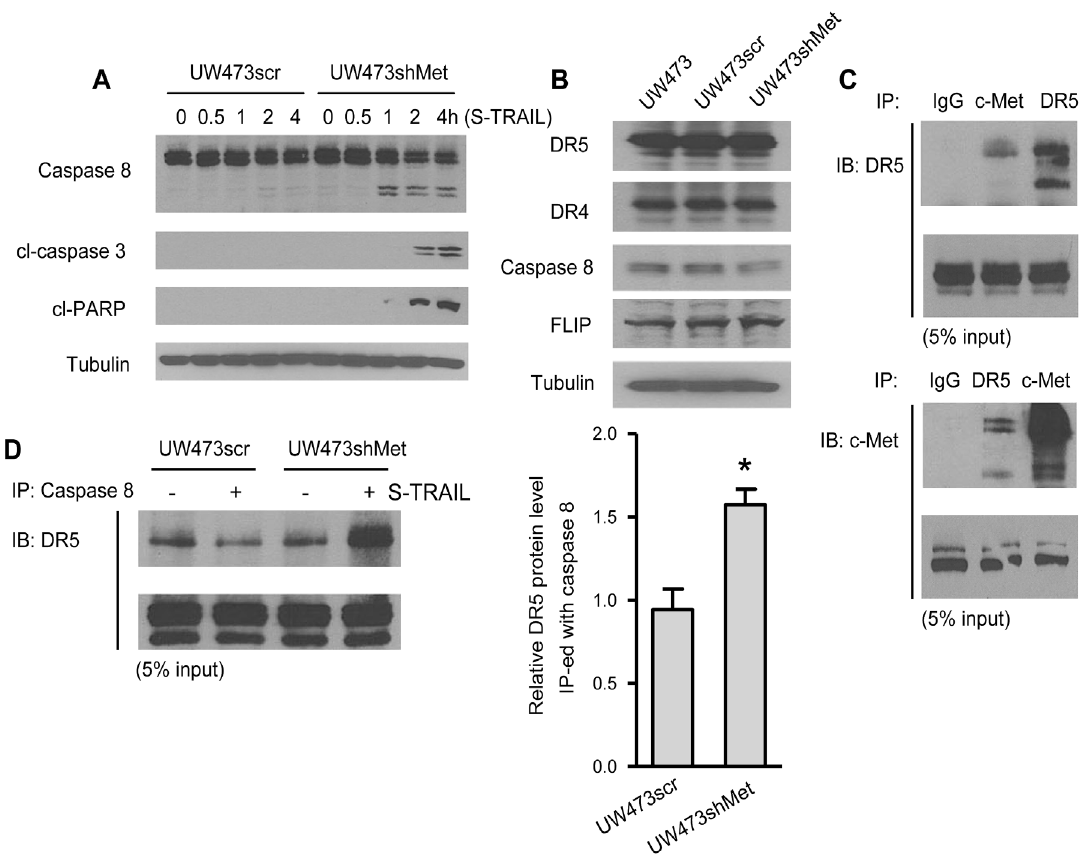
Figure 3. c-Met interacts with DR5 and affects DISC formation upon S-TRAIL stimulation. (A) Western blot analysis of caspase 8, cleaved (cl)-caspase 3, cleaved (cl)-PARP, and tubulin levels in UW473scr and UW473shMet cells upon S-TRAIL stimulation for indicated time periods. (B) Western blot analysis showing DR5, DR4, caspase 8, FLIP, and tubulin levels in UW473, UW473scr and UW473shMet cells. (C) Upper panel, Western blot analysis showing the DR5 levels in the immunoprecipitates of IgG, anti-c-Met, and anti-DR5 (5% of each input was also blotted for total DR5 as control); Lower panel, Western blot analysis showing the c-Met levels in the immunoprecipitates of IgG, anti-DR5 and anti-c-Met (5% of each input was also blotted for total c-Met as control). (D) Left panel, Western blot analysis showing DR5 levels in the immunoprecipitates of anti-caspase 8